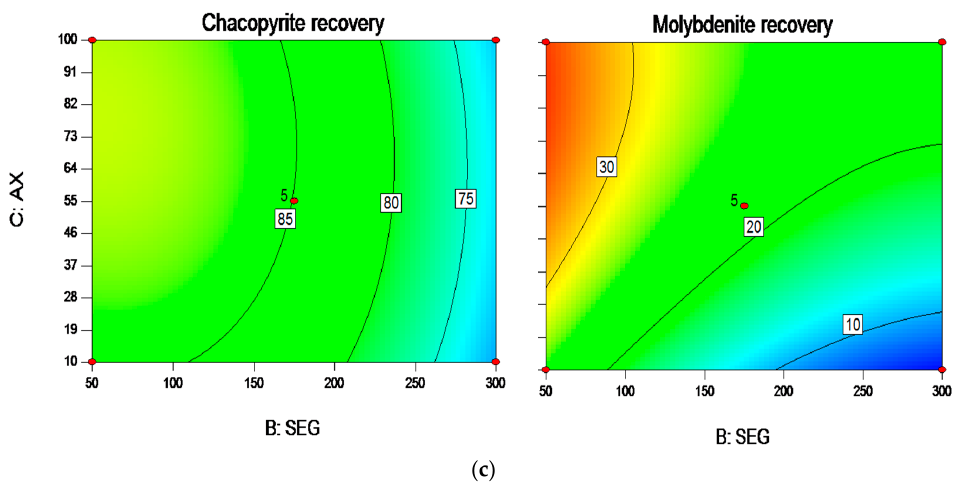
Figure 5. Response surface plots and contours for separation efficiency as a function of ( a ) SEG dosage and pH (amyl xanthate, AX: 20 mg/L); ( b ) pH and AX dosage (SEG: 175 mg/L); and ( c ) SEG dosage and AX dosage (pH = 3.4). Table 4. Predicted and experimental values of the responses of optimum conditions.